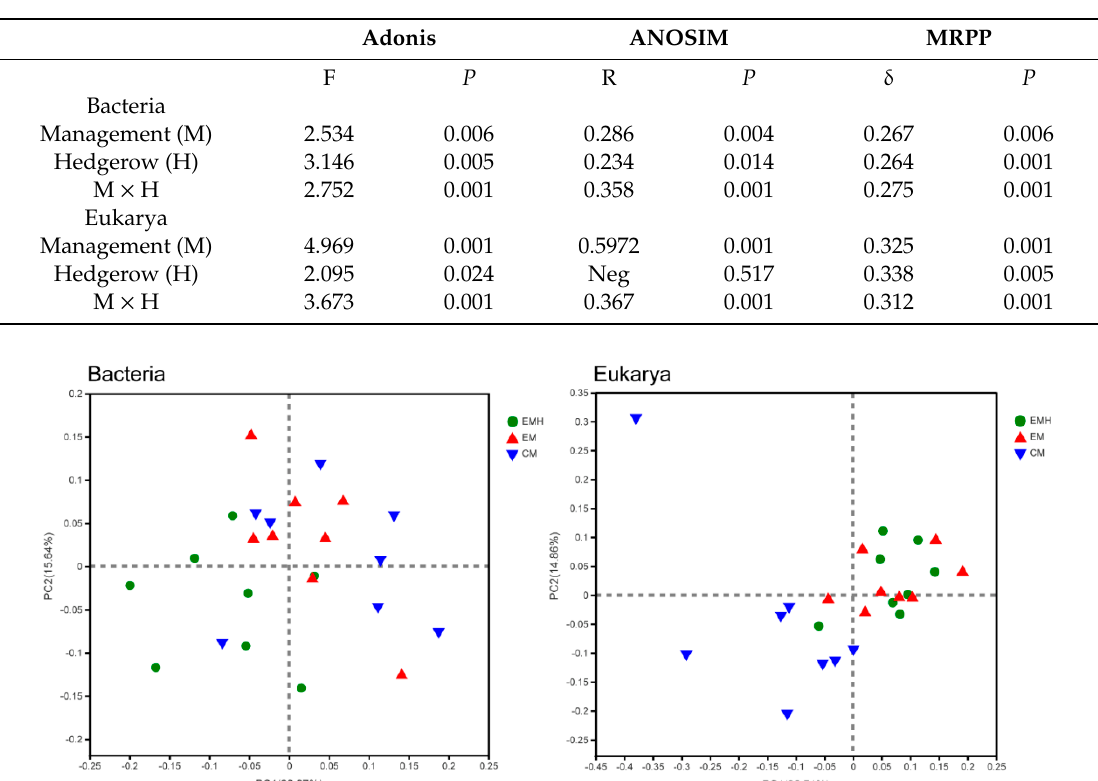
Table 1. E ff ects of management and hedgerow on bacterial and eukaryotic beta-diversity as assessed by the three complementary non-parametric multivariate statistical tests.